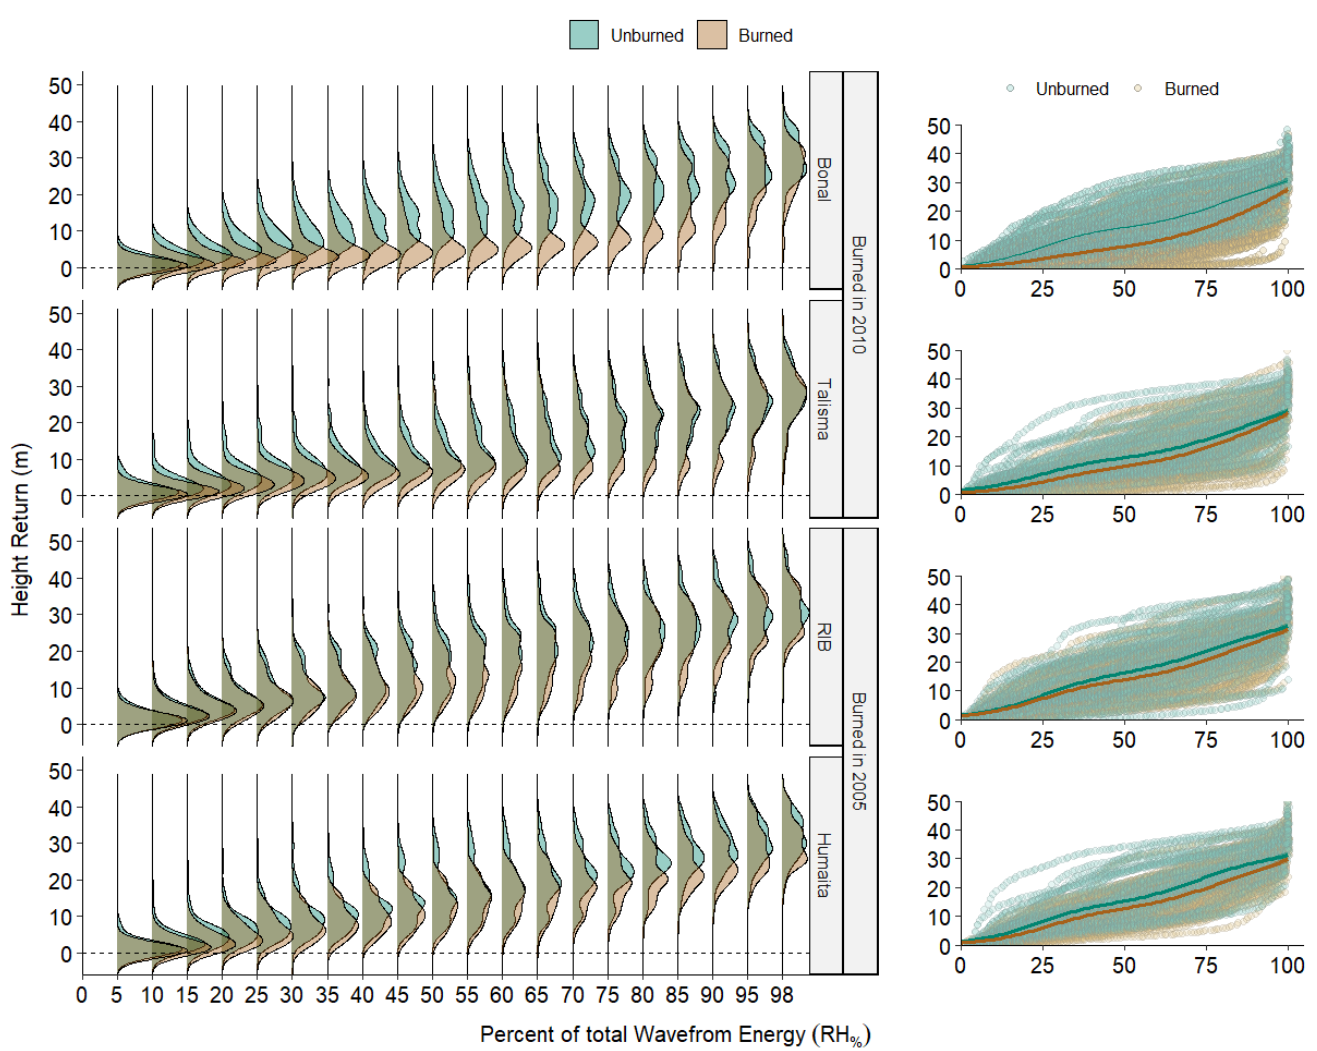
Figure 6. Left column graphs depict density distribution plots of height returns at relative height percentile (RH) slices through the canopy broken down by burn status (burned in green and unburned in orange) and by study site. The right column graphs are in the same scale and color scheme but have fitted GAM curves and 95% confidence intervals overlaying all rh data points at each study site.